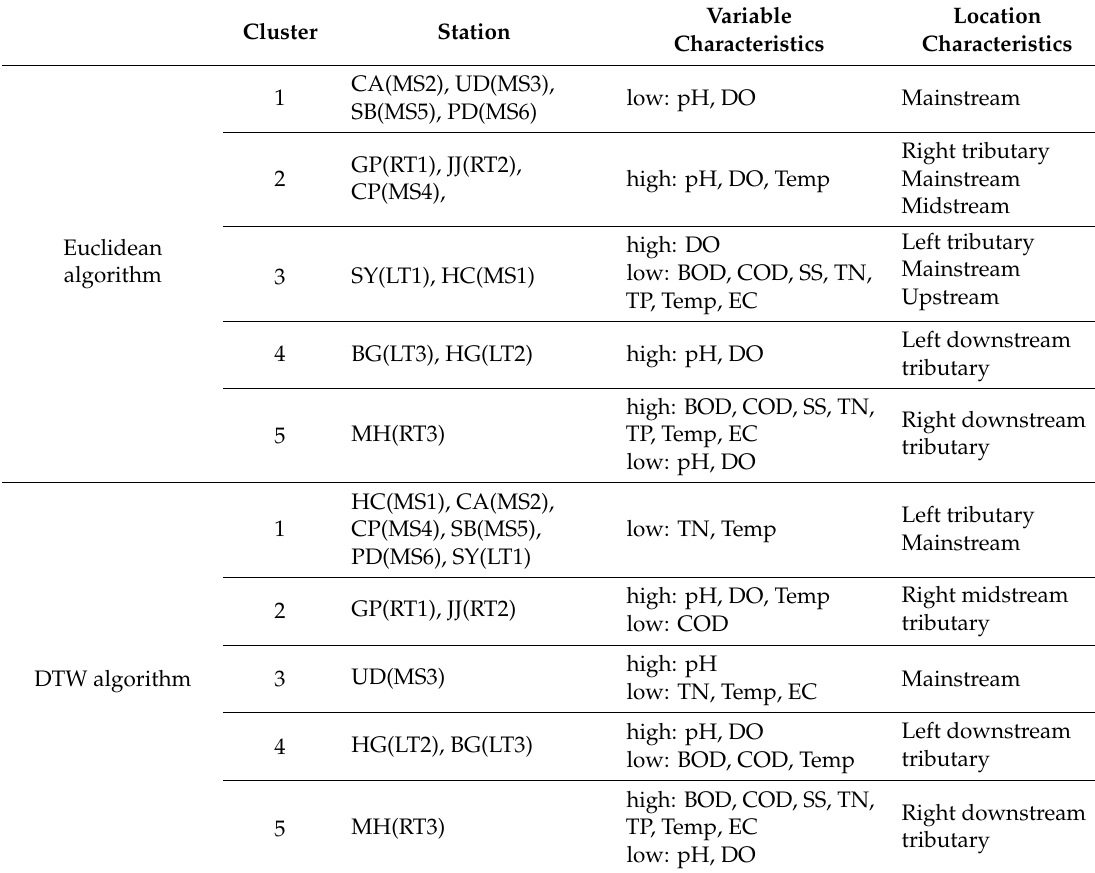
Table 6. Cluster characteristics for the Euclidean and Dynamic Time Warping (DTW)